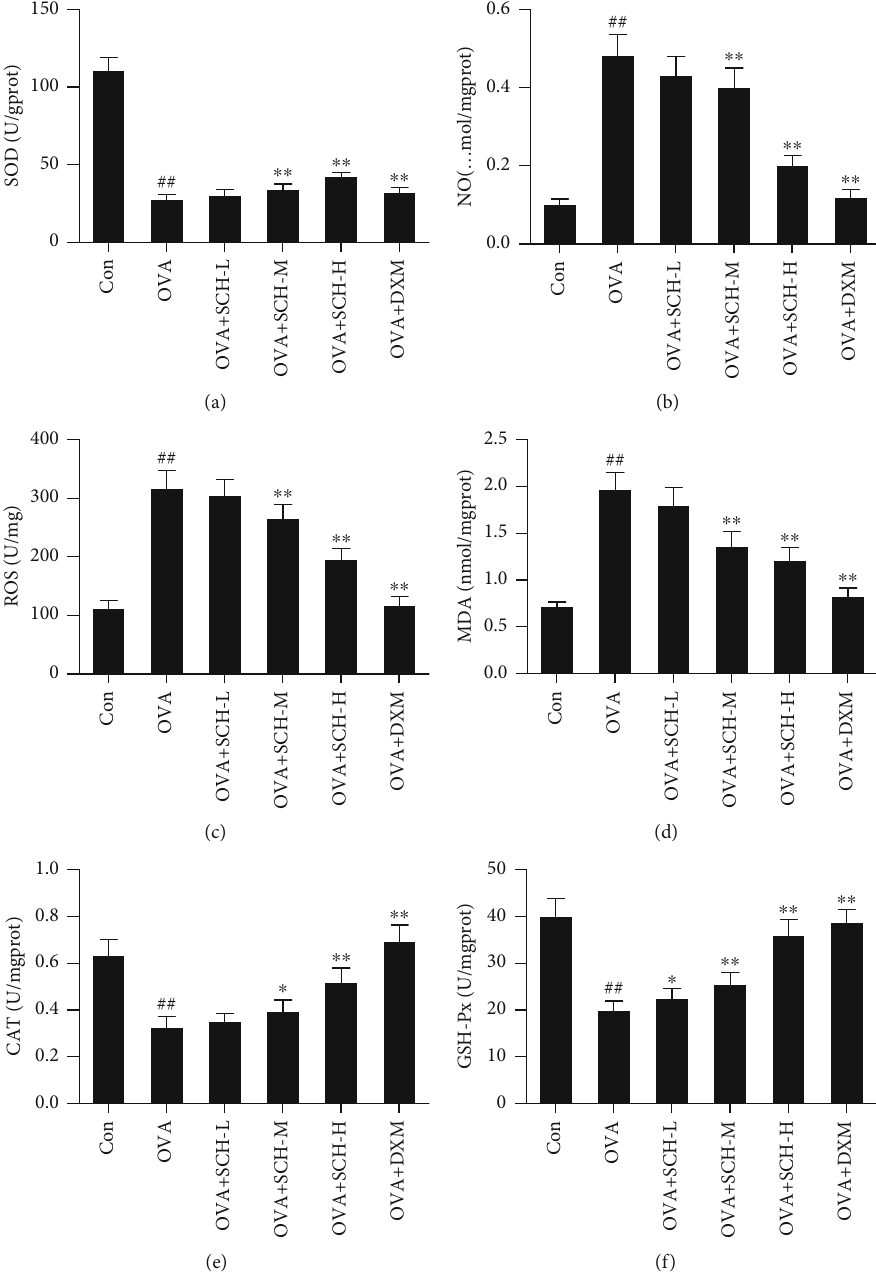
Figure 6: Antioxidant e ff ects of SCH on the lung. The levels of (a) SOD, (b) NO, (c) ROS, (d) MDA, (e) CAT, and (f) GSH-Px in lung tissues were investigated to evaluate the antioxidant function of SCH. Data are presented as the means ± SD ; n = 6 . ## p < 0 : 01 compared with the control group; ∗∗ p < 0 : 01 and ∗ p < 0 : 05 compared with the OVA group. MDA: malondialdehyde; SOD: superoxide dismutase; ROS: reactive oxygen species; NO: nitric oxide; GSH-Px: glutathione peroxidase; CAT: